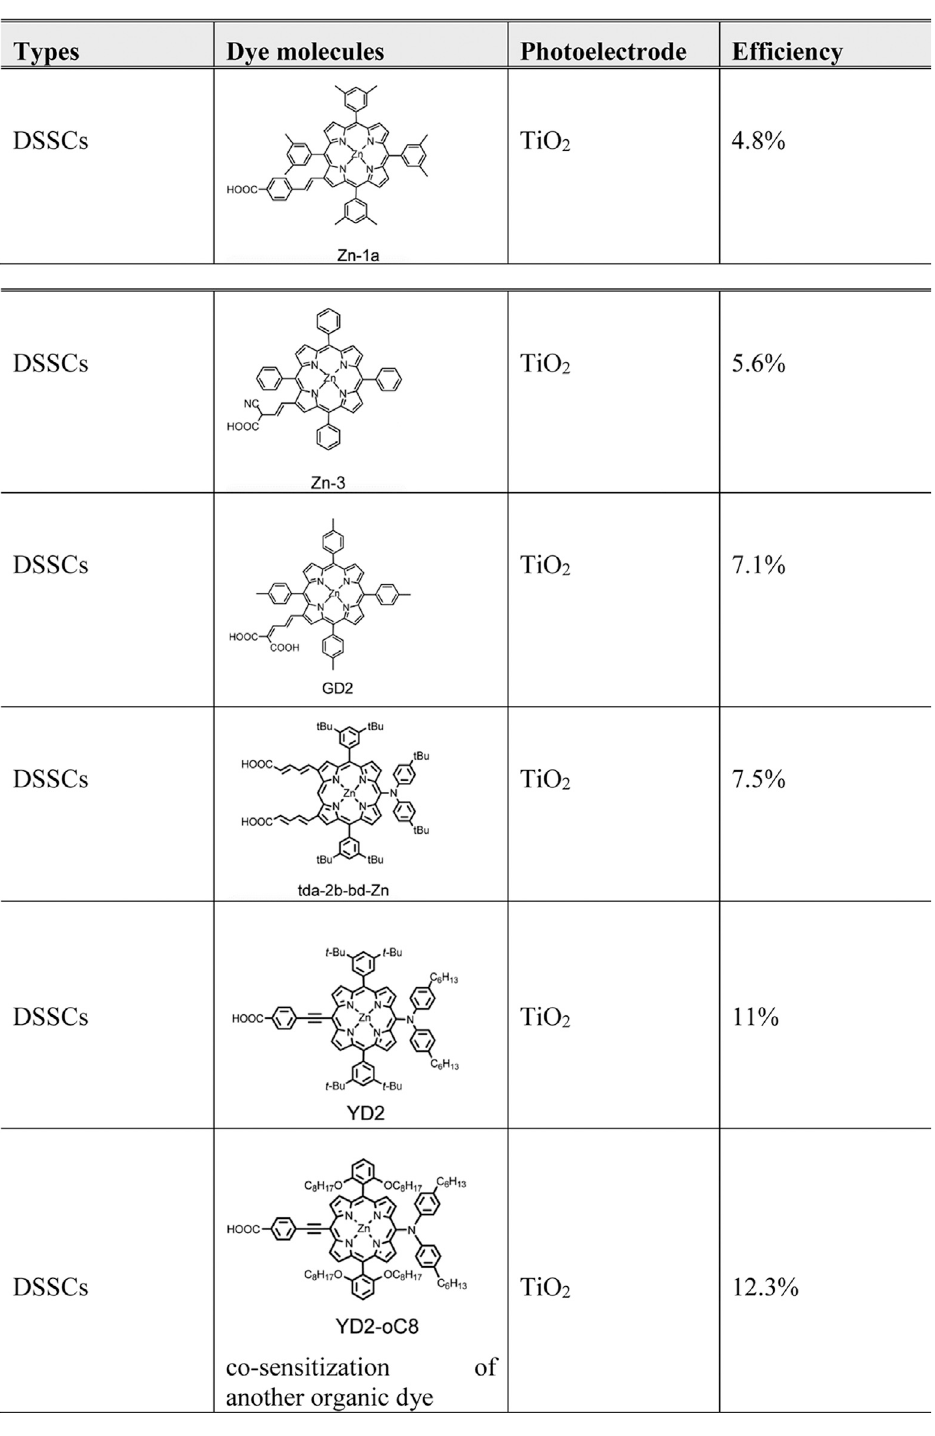
TABLE 4 | Porphyrin molecules used in some DSSCs which obtain high ef fi ciency.